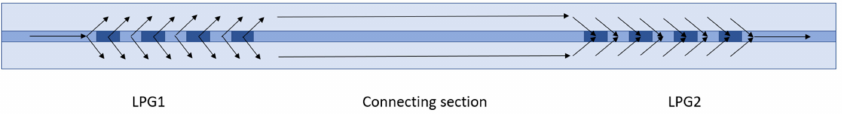
Figure 1. LPGMZI